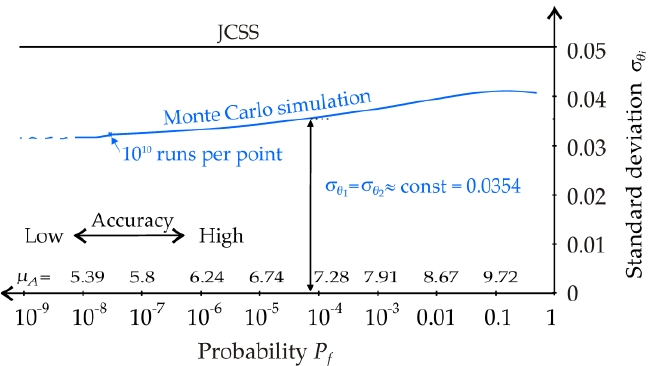
Figure 7. Course of the standard deviation of model uncertainty compared to [27] — case study 1.